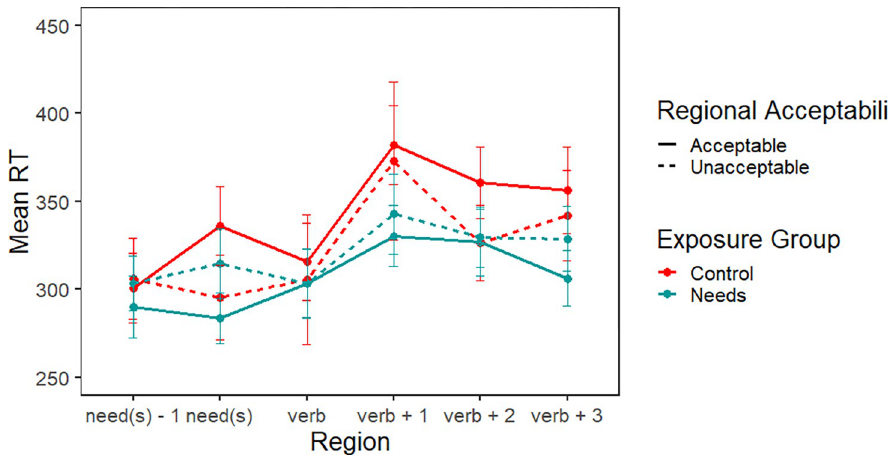
Fig 2. Experiment 1 test block. Mean reading times for critical sentence regions by acceptability of the regional structure (acceptable vs. unacceptable) and exposure group (Control vs.